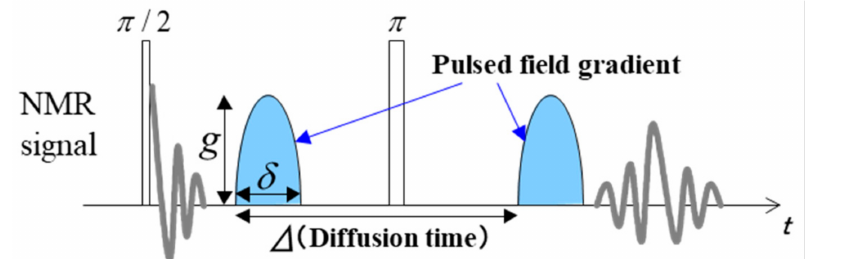
Figure 1. Typical pulse sequence for the diffusion coefficient measurement. In the evaluation of the T 2 behavior, an echo signal with δ = 0 (without the application of the gradient